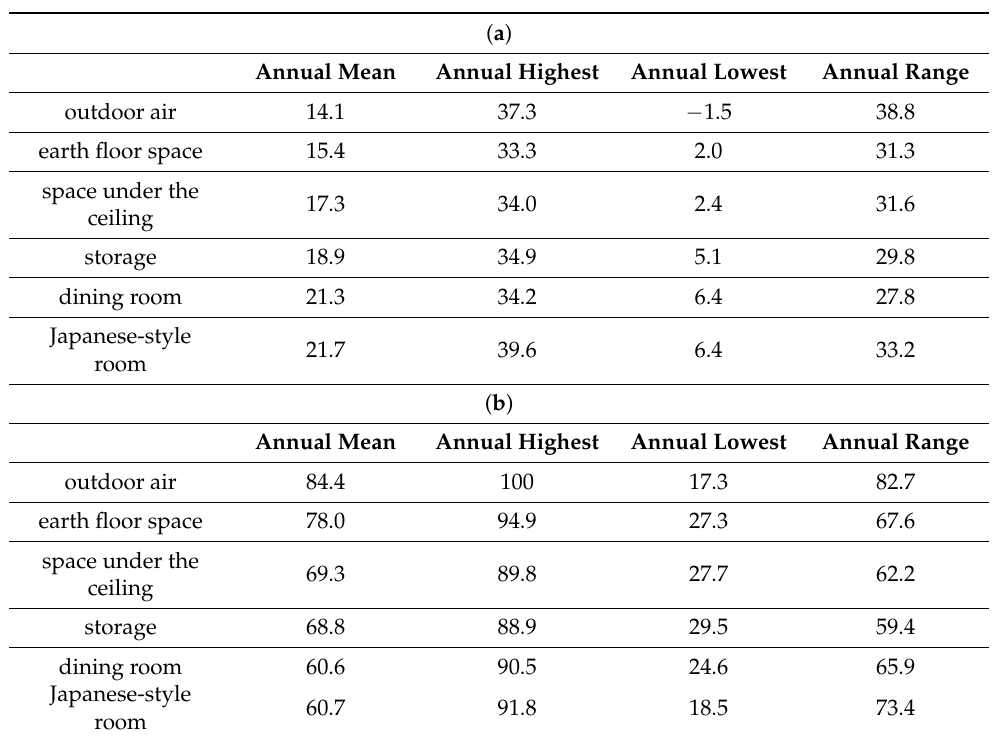
Table 1. Annual average value, annual highest value, annual lowest value, and annual range of ( a ) temperature ( ◦ C) and ( b ) relative humidity (%) in 2019 at each location. All the values in these tables are rounded off to one decimal